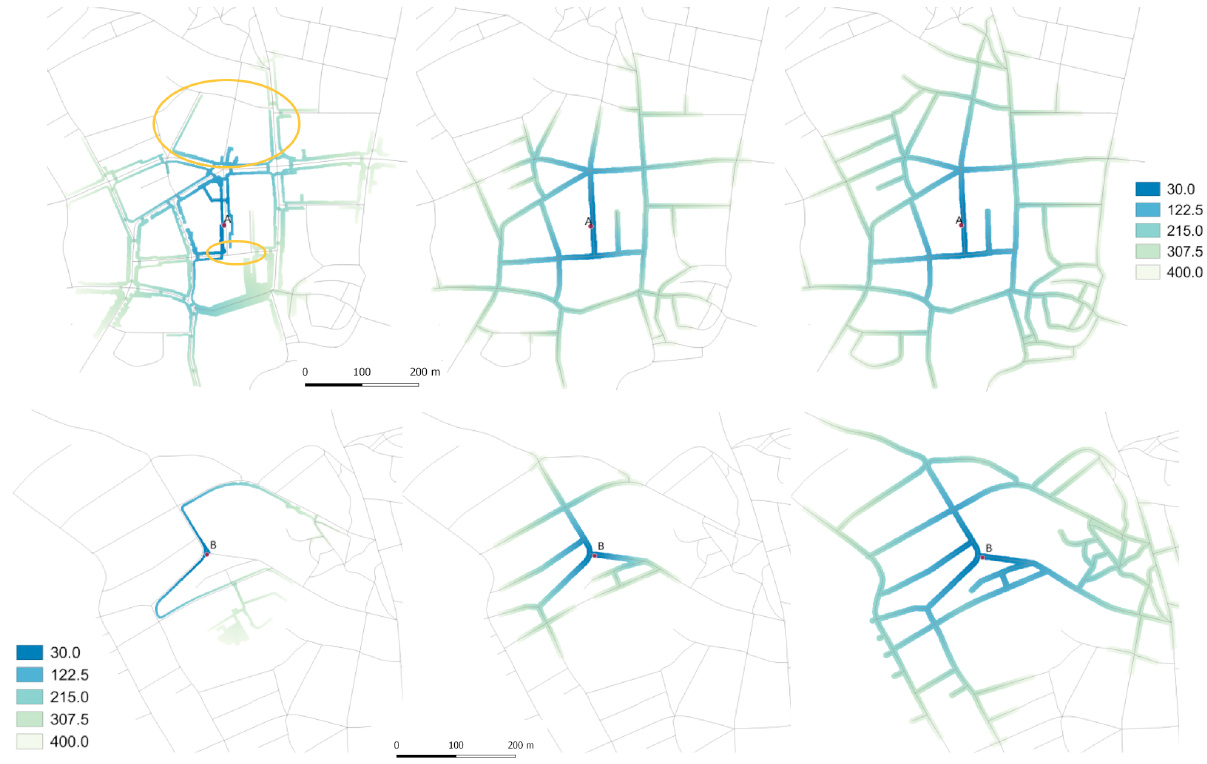
Figure 4. Cost distance maps for location A (top row) on footpath network 1 (left), on footpath network 2 (middle), on street network (right). Cost distance maps for location B (bottom row) on footpath network 1 (left), on footpath network 2 (middle), on street network (right). (Data Sources: Amt für Geoinformation Kanton Solothurn 2016; Direktion für Öffentliche Sicherheit, Stadt